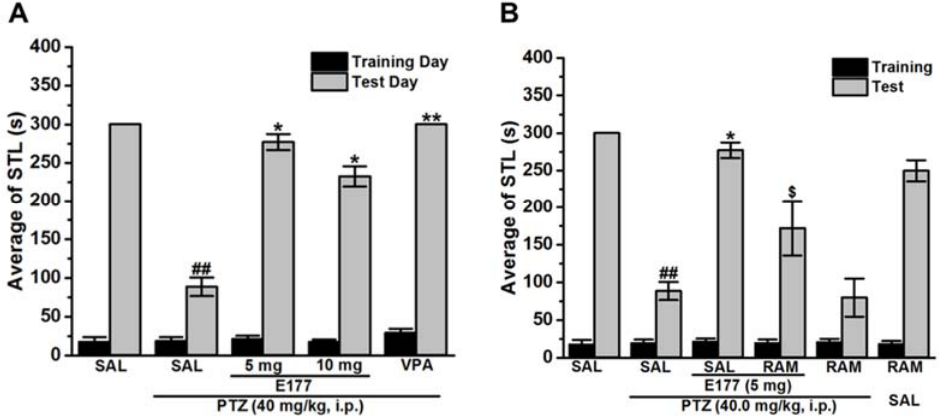
Figure 2. H3R antagonist E177 treatment counteracted PTZ-induced memory deficits in inhibitory avoidance paradigm. Average STL time measured on the first training day before the delivery of foot shock (black columns), and average STL time measured on the test day (gray columns). ( A ) STL time measured on the test day (gray columns). ## P < 0.001 for average STL time compared with that of the SAL-treated group. * P < 0.05 for average STLs compared with the PTZ-kindled group. ** P < 0.001 for average STLs compared with the PTZ-kindled group. The data are expressed as the mean ± SEM ( n = 6). ( B ) E ff ect of chronic co-injection of E177 (5 mg / kg) with RAM (10 mg / kg) before each PTZ injection on the average of STL time. $ P < 0.05 for average STLs compared with the H3R antagonist E177 (5 mg)-treated rats. The data are expressed as the mean ± SEM ( n = 6).